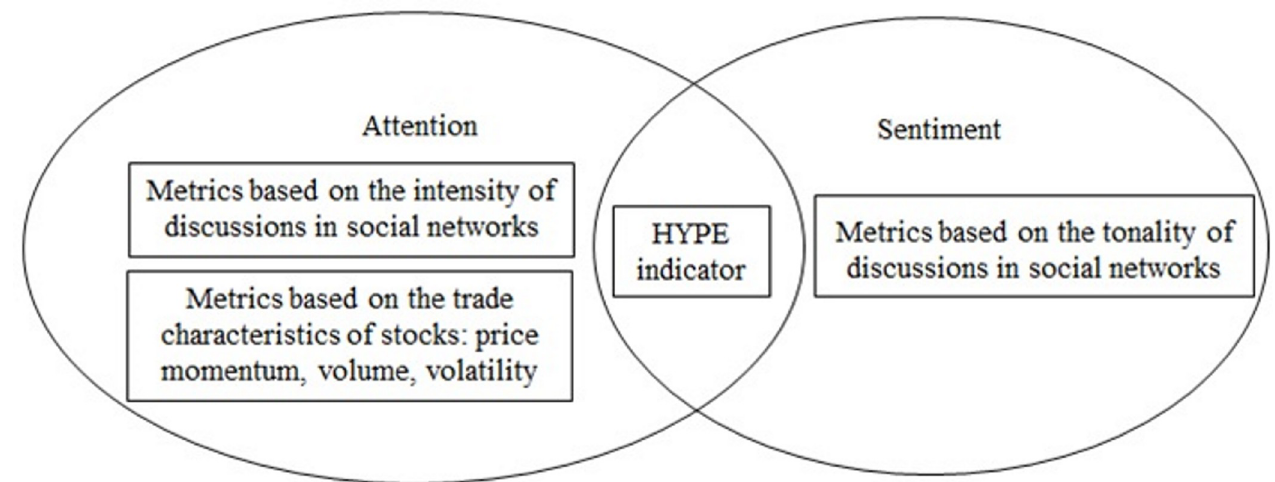
Fig 1. Metrics under consideration and the novel Hype indicator. Source: the authors’ classification.